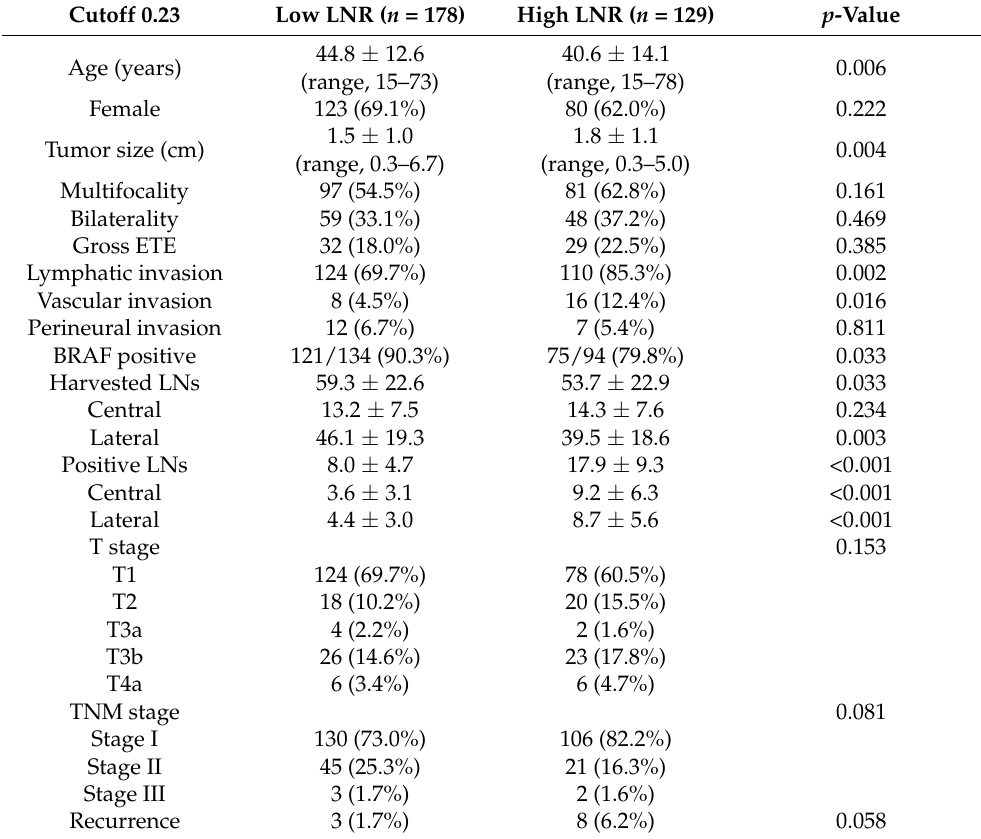
Table 1. Comparison of baseline clinicopathological characteristics according to LNR (whole).